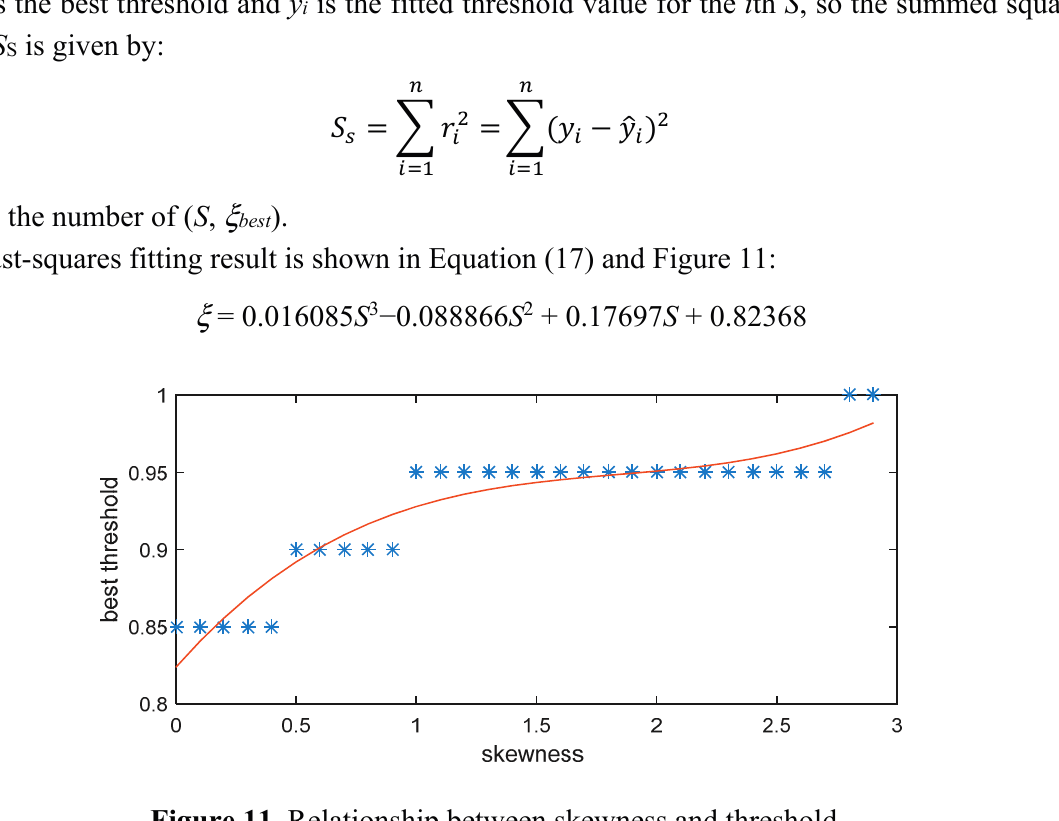
Figure 11. Relationship between skewness and